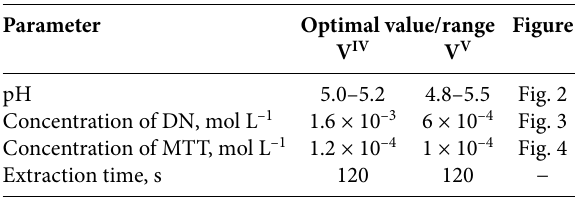
Table 1. Optimum conditions for extraction of the ternary com- plexes